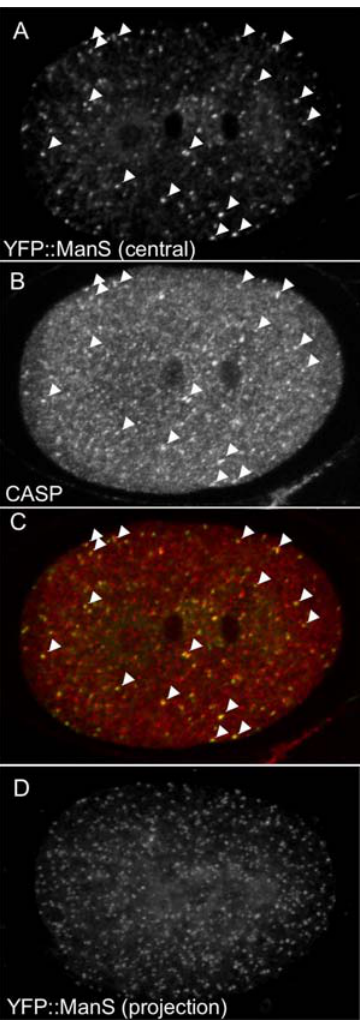
Figure 2. The Golgi shows no asymmetry in distribution during the first cell cycle. (A–C) Even distribution of Golgi structures in a wild-type telophase embryo. The Golgi is visualized using two markers: (A) YFP::ManS, a fusion of YFP and the Golgi resident mannosidase F58H1.1 and (B) anti-CASP/Y54F10AM.4b staining. CASP is an integral Golgi membrane protein [17]. Arrowheads in (A), (B), and (C) (the merged image) show colocalization of puncta with the two markers. Central focal planes are shown. (D) even distribution of Golgi structures in a projection of 12 focal planes of YFP::ManS in a wild-type anaphase stage